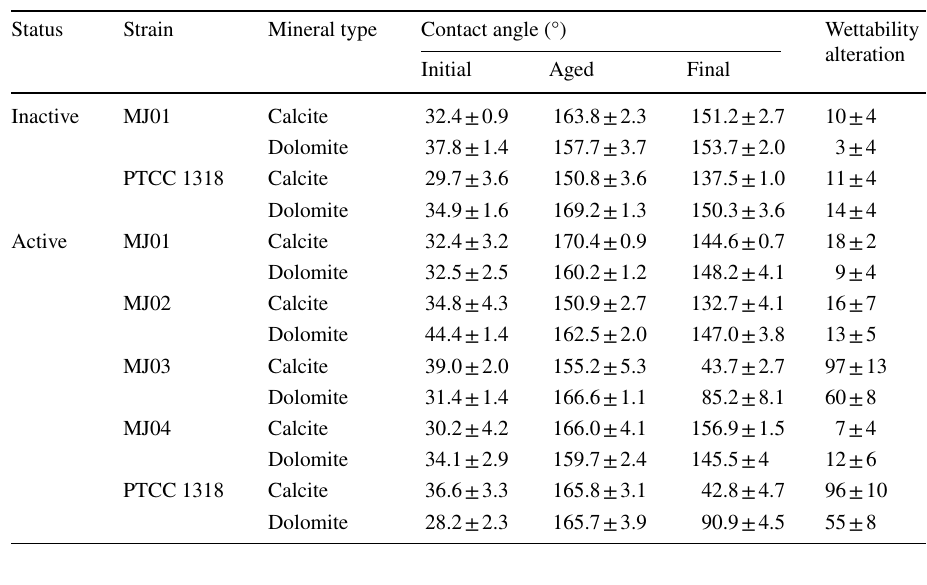
Table 3 Contact angle measurements for calcite and dolomite rock slices before aging, after aging and after treatment by active and inactive bacteria